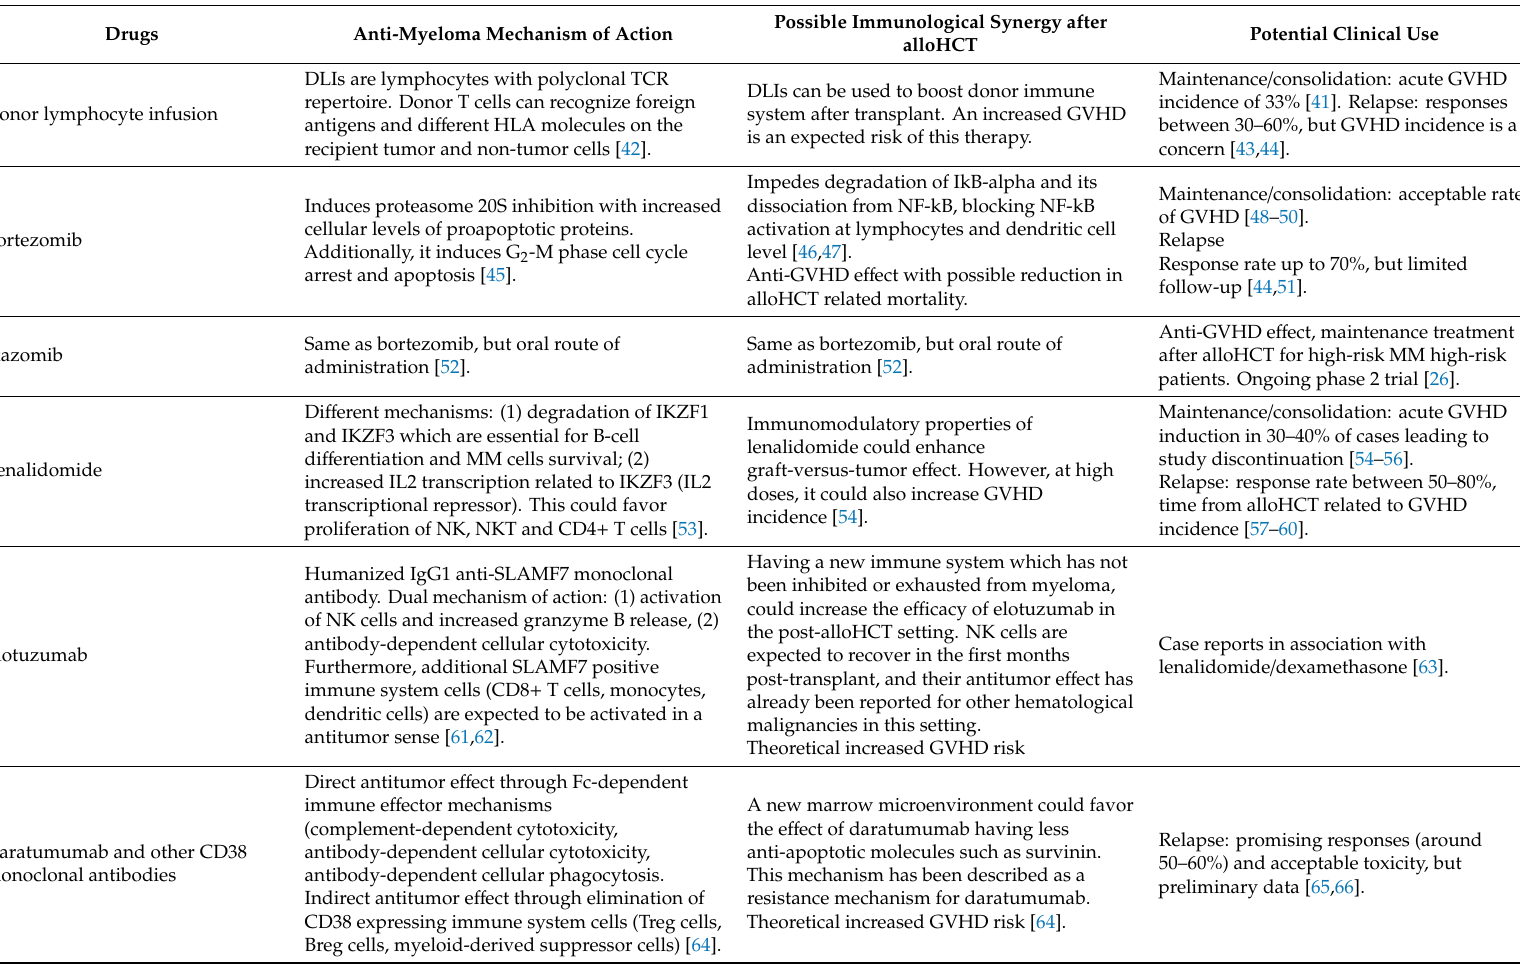
Table 3. Drugs available for treating multiple myeloma and their principal mechanism of action in the post-allogeneic transplantation